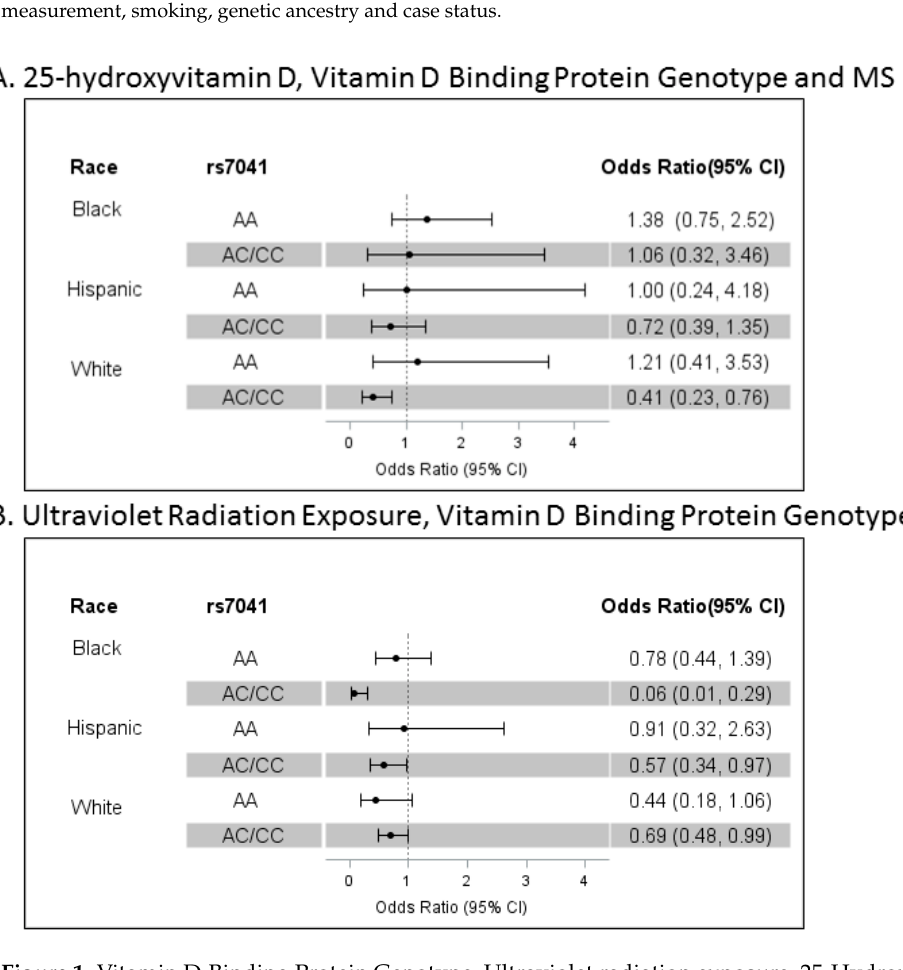
Figure 1. Vitamin D-Binding Protein Genotype, Ultraviolet radiation exposure, 25-Hydroxyvitamin D and MS. Depicted are the odds ratios (ORs) and 95% confidence intervals (CIs) of the independent associations of serum 25-hydroxyvitamin D levels (Panel A ) or cumulative lifetime ultraviolet radiation exposure (Panel A ) with risk of multiple sclerosis/clinically isolated syndrome stratified by dominant genotype of SNP rs7041 within each racial/ethnic group. Serum 25-hydroxyvitamin D levels were log transformed and adjusted for BMI and season. Odds ratios are adjusted by age, sex, smoking, genetic ancestry, HLA-DRB1*15:01 (rs3135388) 25-hydroxyvitamin D (Panel A ) or lifetime ultraviolet radiation exposure (Panel B ). In blacks, AA is the most common genotype ( n = 173, 70.0%; AC/CC n = 74, 30.0%). Among Hispanics, the distribution is AA n = 87, 22.9% and AC/CC n = 293, 77.1%; in whites, AA n = 108, 21.0% and AC/CC n = 406, 79.0%.